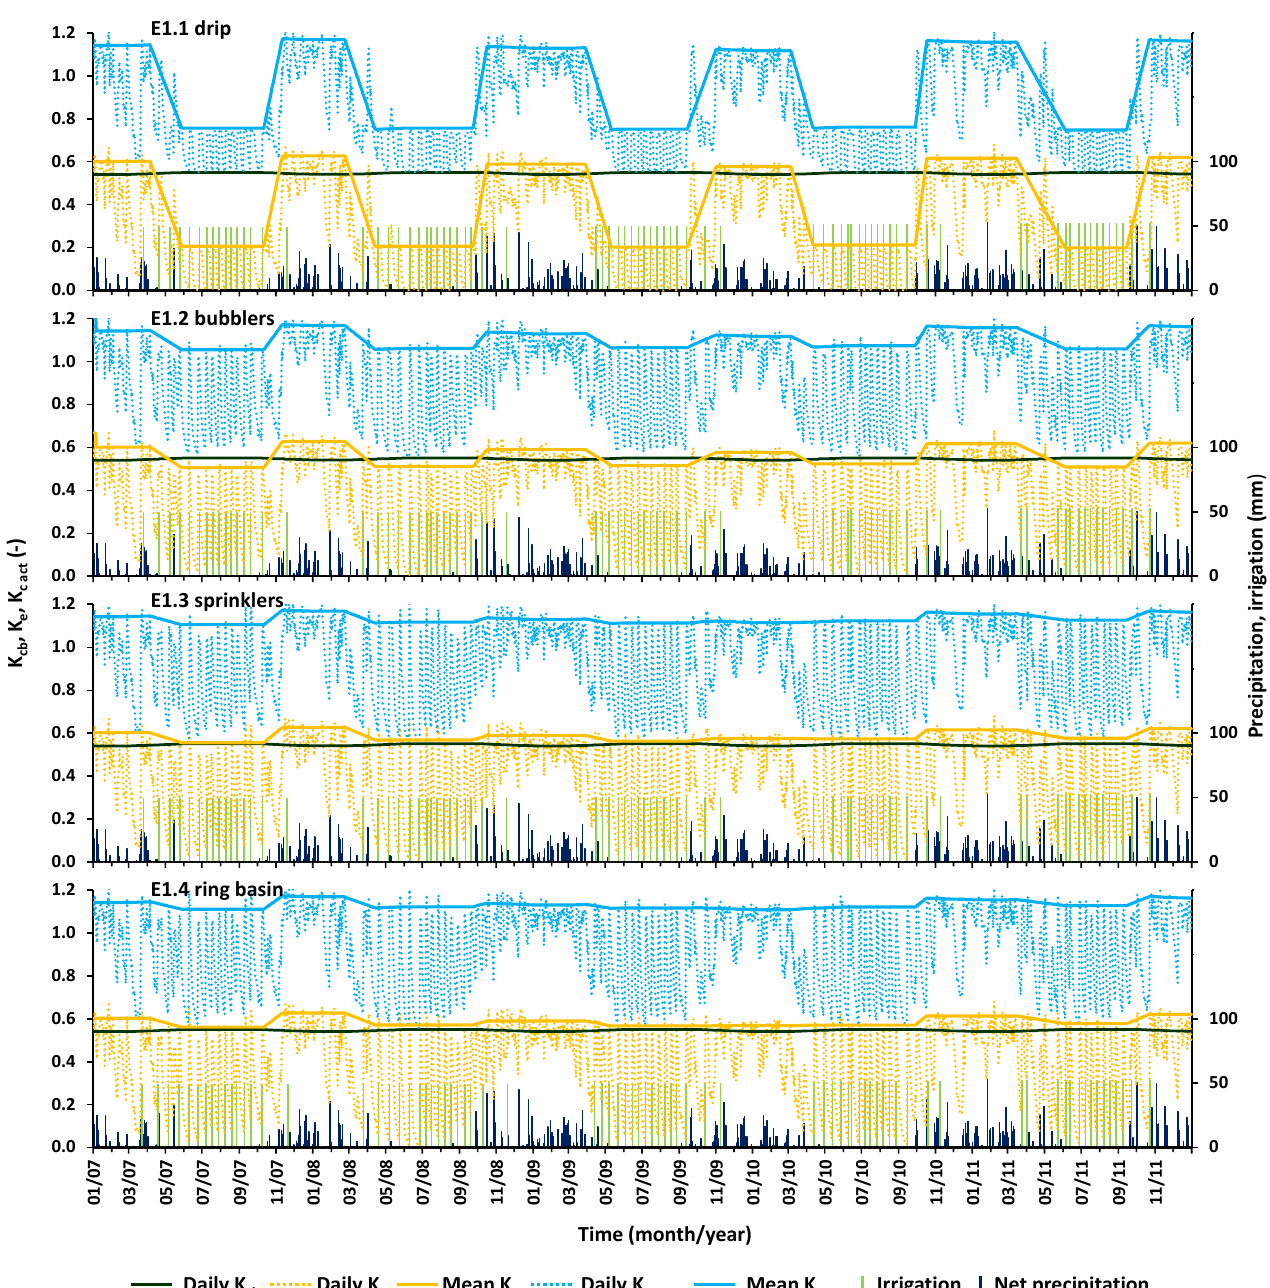
Figure 6. Seasonal variation in the standard (non-stressed) basal crop coefficient (K cb ), the actual basal crop coefficient (K cb act ), and the evaporation coefficient (K e ) in E1.1 drip, E1.2 bubbler, E1.3 micro-sprinkling, and E1.4 ring-basin plots during the 2007–2011 growing seasons, including the respective data on irrigation and precipitation.